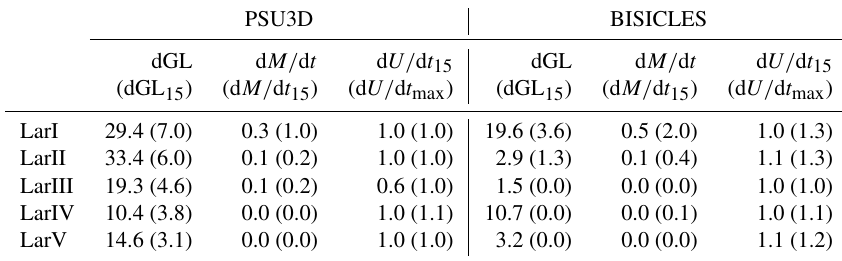
Table A3. Same as for Table A1 but for Experiment 2.